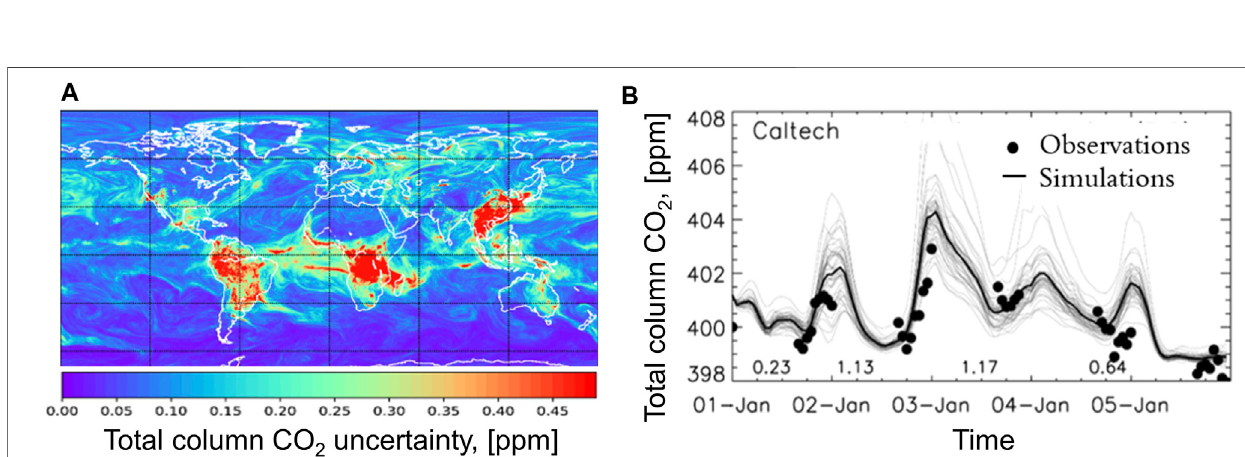
Frontiers in Remote Sensing |